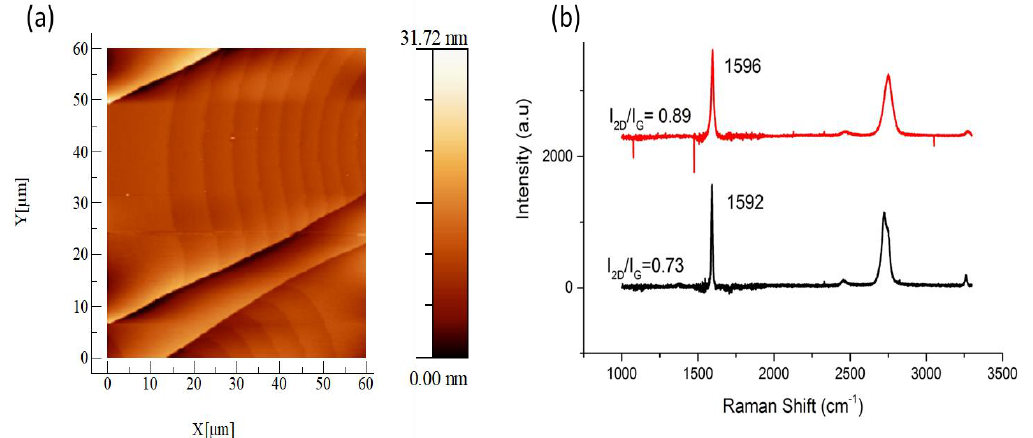
Figure 1. ( a ) 60 × 60 µ m 2 AFM image of the graphene on SiC which we used for balun circuits. ( b ) Two representative Raman spectra of our graphene, the SiC background Raman signal has been subtracted.